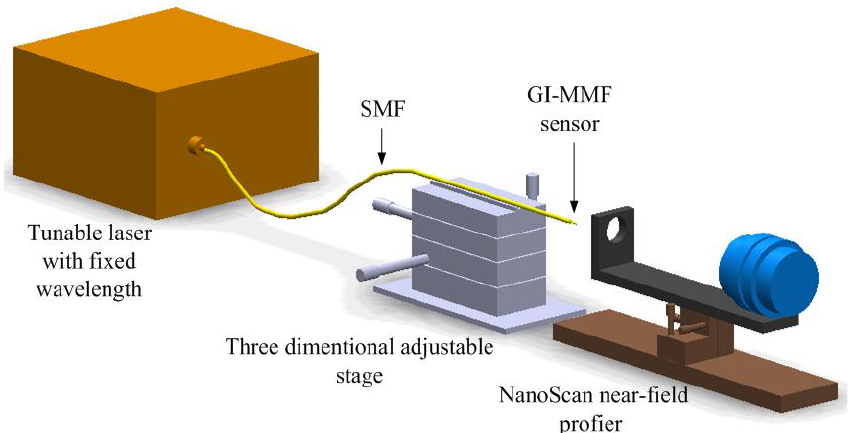
Figure 2. Schematic diagram of experimental setup for the spot size